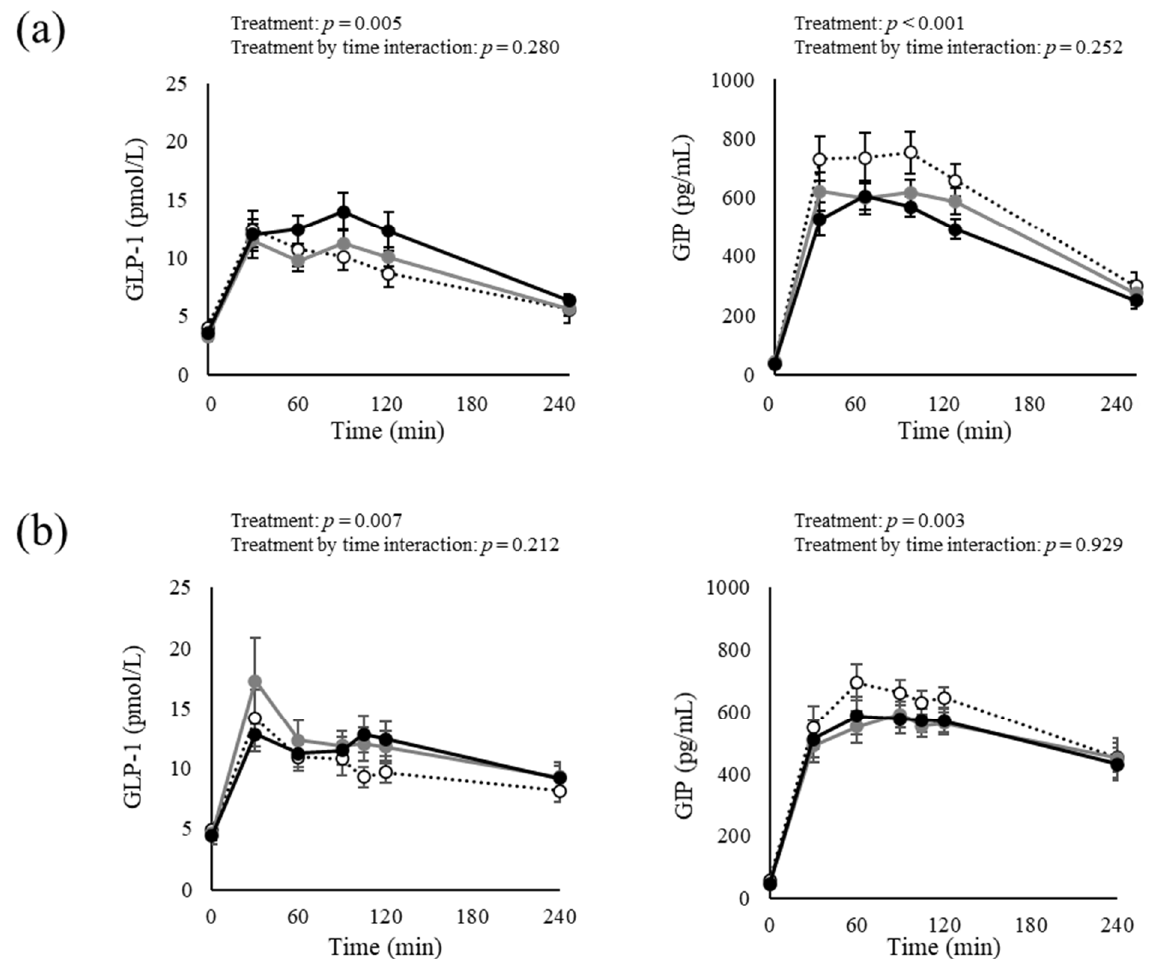
Figure 2. Changes in blood test results at fasting and after cookie meal consumption for Study 1 ( a ) and Study 2 ( b ). Data are expressed as mean ± SEM. ( a ) White circles indicate the Placebo. Gray and black circles indicate Dose A (270 mg GTC, 270 mg CCA, with 113 mg caffeine) and Dose B (540 mg GTC, 270 mg CCA, with 113 mg caffeine), respectively. Treatment main effects and treatment × time interactions were analyzed by linear mixed-effect models ( n = 18). ( b ) White circles indicate the Placebo. Gray and black circles indicate Dose C (540 mg GTC, 150 mg CCA, with 99 mg caffeine), and Dose D (540 mg GTC, 300 mg CCA, with 99 mg caffeine), respectively. Treatment main effects and treatment × time interactions were analyzed by linear mixed-effect models ( n = 18; Placebo, n = 17; Dose C and Dose D). Abbreviations: CCA, coffee chlorogenic acid; GIP, glucose-dependent insulinotropic polypeptide; GLP-1, glucagon-like peptide-1; and GTC, green tea